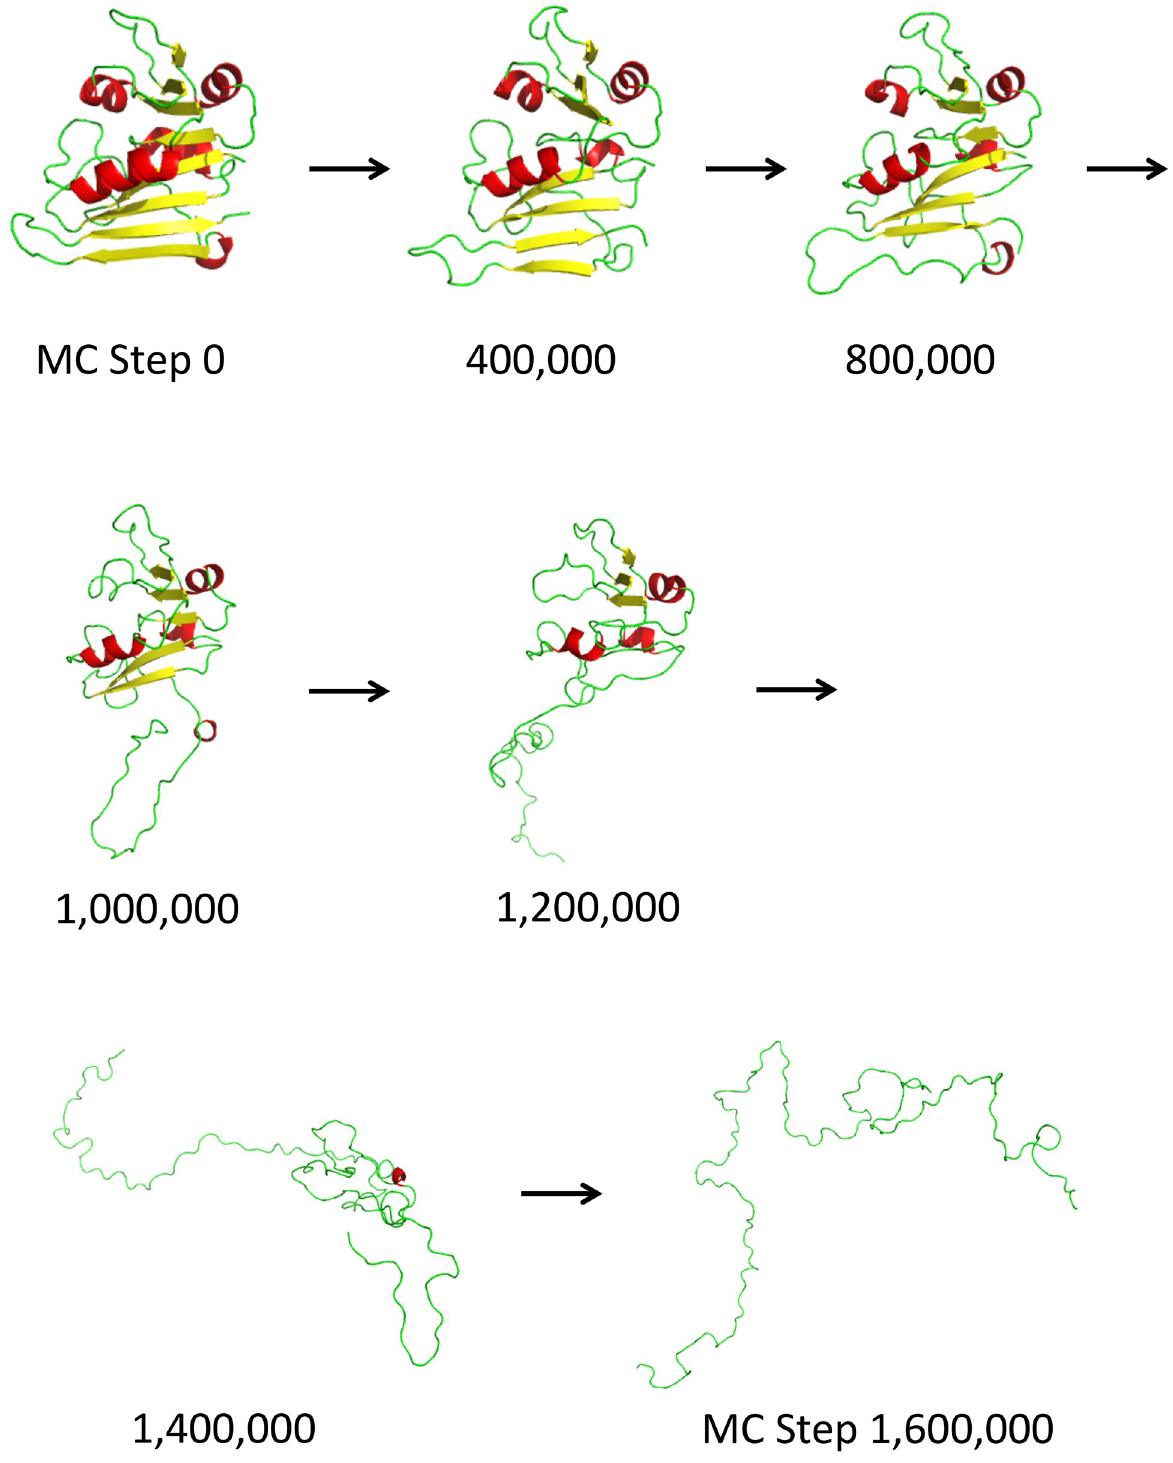
Fig 2. A sample WT DHFR unfolding trajectory at simulation temperature 1.5 (arbitrary simulation units). In MC simulations, separation of the C-terminal beta hairpin from the rest of the protein (steps 1,000,000 through 1,200,000) is an early event in the unfolding process.